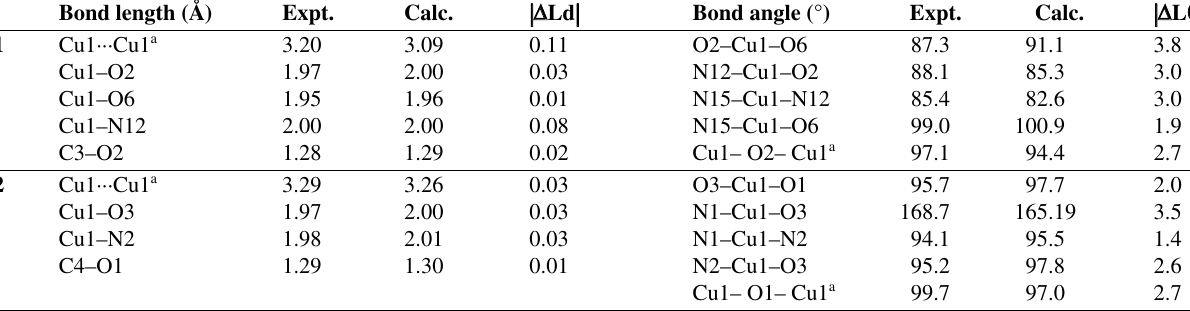
Table 4. Selected geometric parameters from X-ray and DFT-B3LYP calculations Bond length (Å) Expt. Calc. ||ΔΔ Ld || Bond angle (°) Expt.